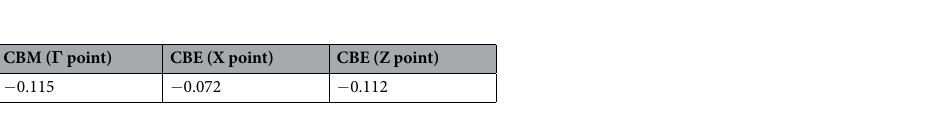
Table 1. The energy eigenvalues (in unit of eV) of CBM and two CBEs of Hf 0.5 Zr 0.5 NiSn 0.98 Sb 0.02